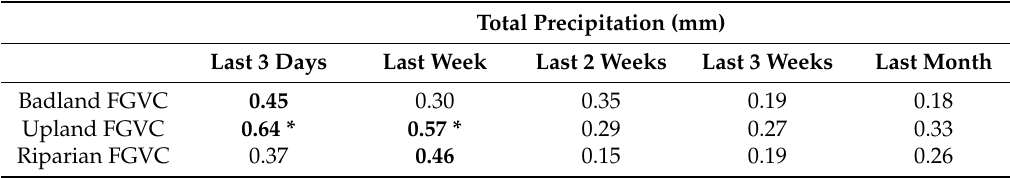
Table 2. Correlations between the unmixed FGVC and total precipitation from the last 3 days to the last month before the images were